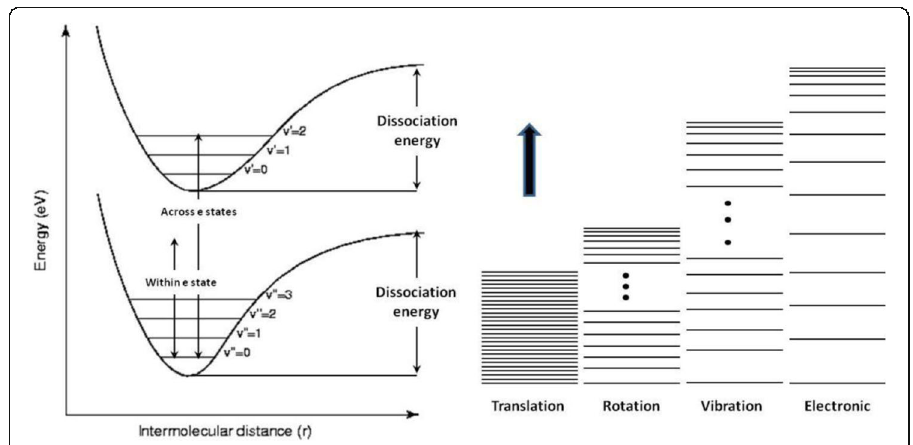
Fig. 15 Schematic quantum spectrum of internal energy of a gas